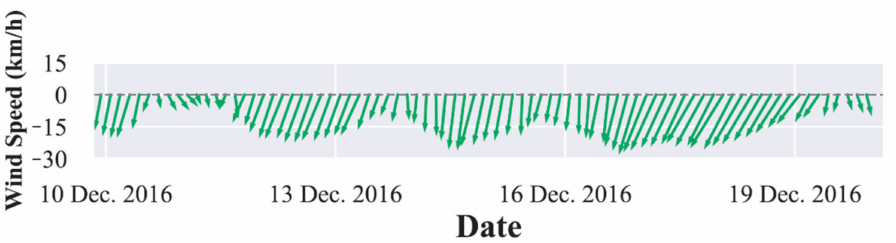
Figure 3. Wind speed and orientation (3 h) near the north of Hall Basin from 10 December 2016 to 20 December 2016.